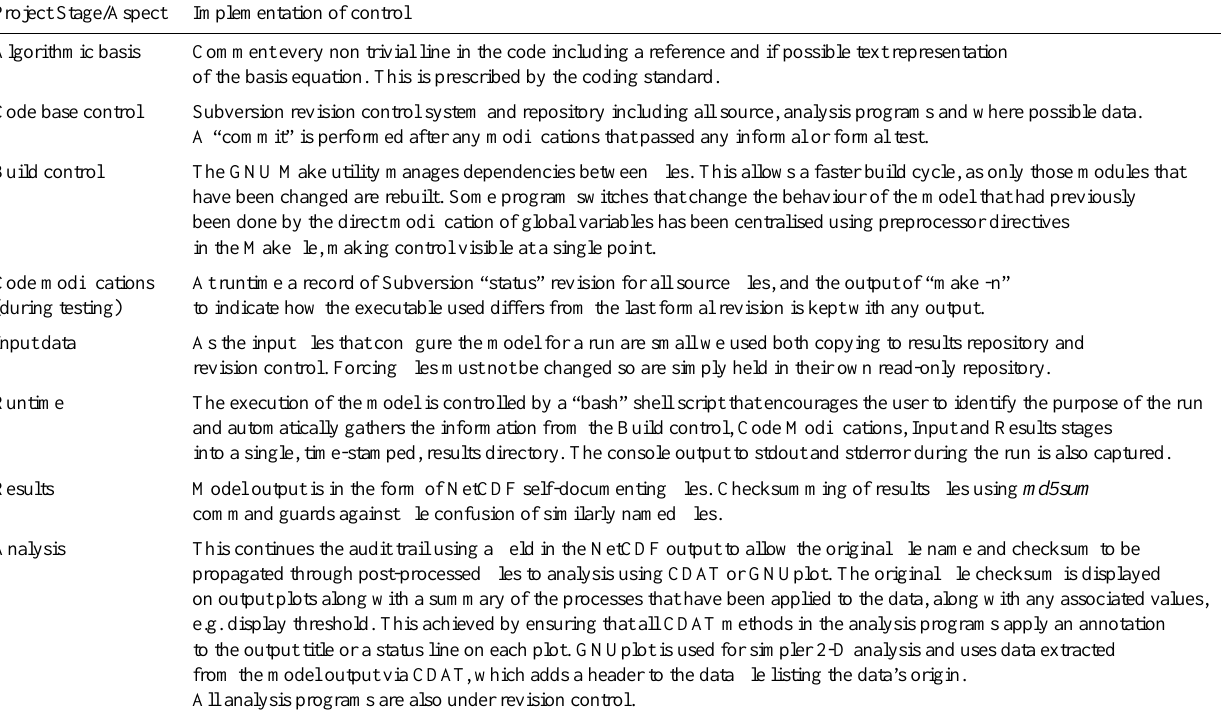
Table A1. Traceability methods – key